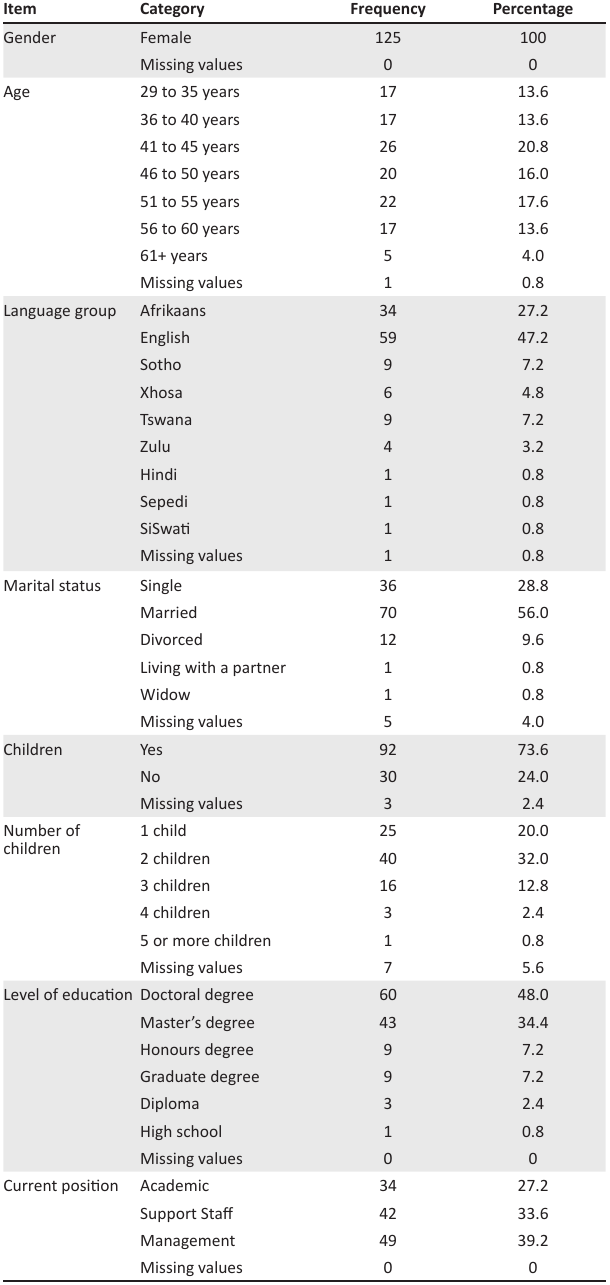
TABLE 1: Characteristics of participants. Item